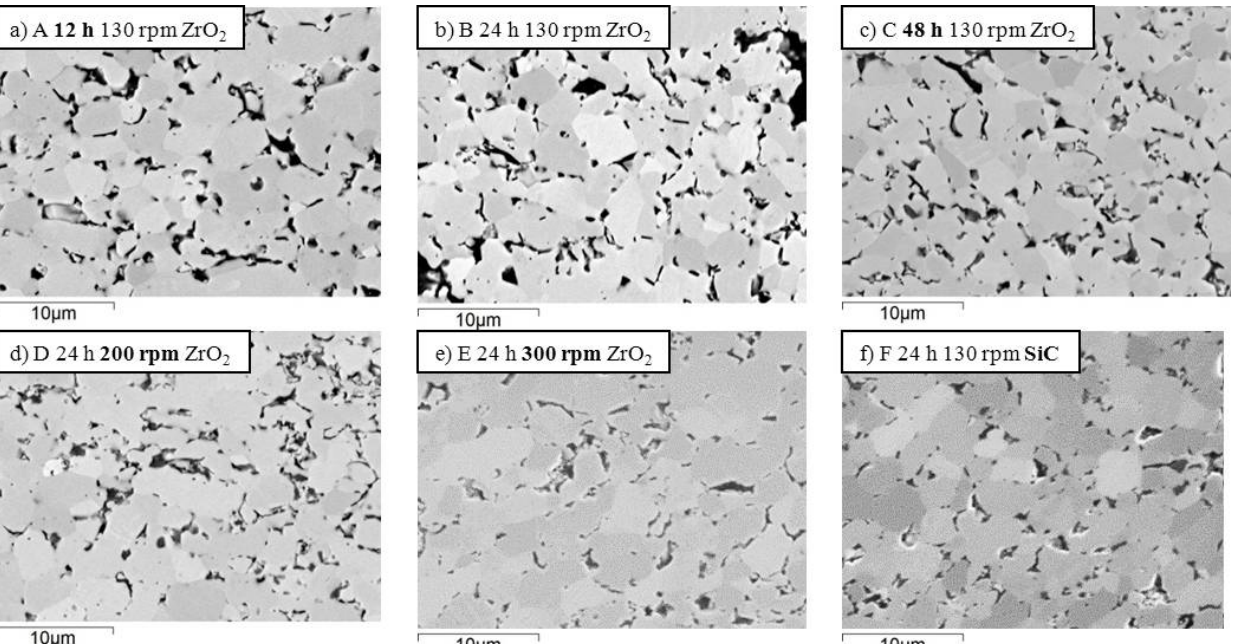
matrix. The dark features 2